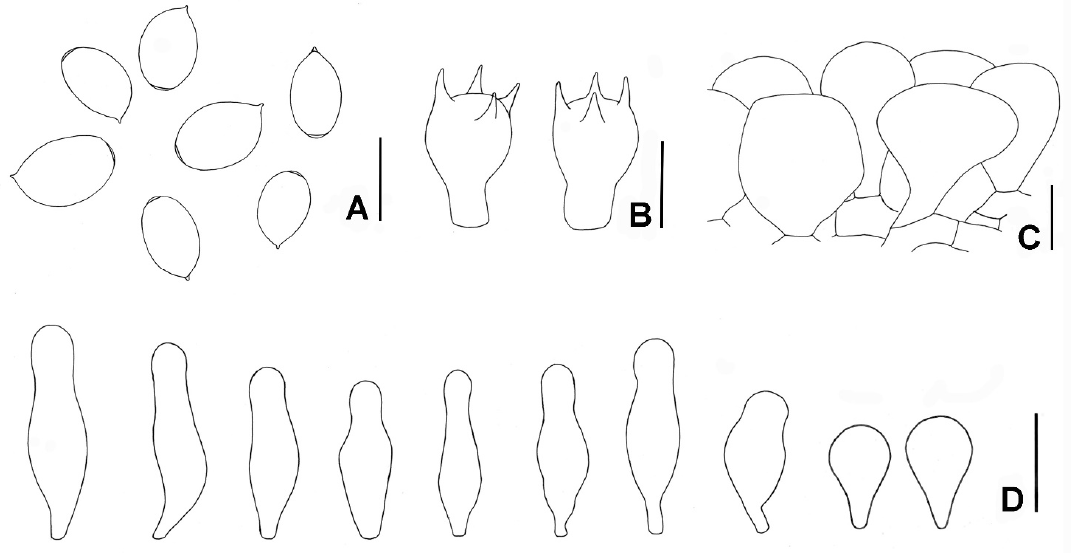
Figure 4. Hausknechtia leucosticta . ( A ) Basidiospores. ( B ) Basidia. ( C ) Pileipellis. ( D ) Cheilocystidia. Bars: ( A – C ) = 10 µm, ( D ) = 20 µm.